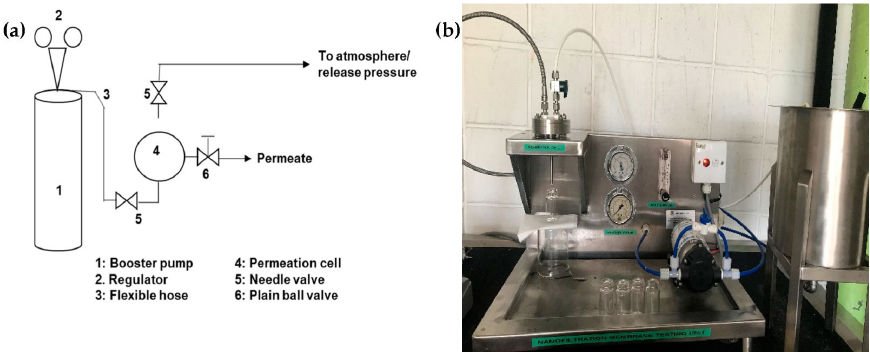
Figure 1. ( a ) Picture illustrates the crossflow membrane filtration setup for lab scale and ( b ) the schematic diagram of the permeation system.